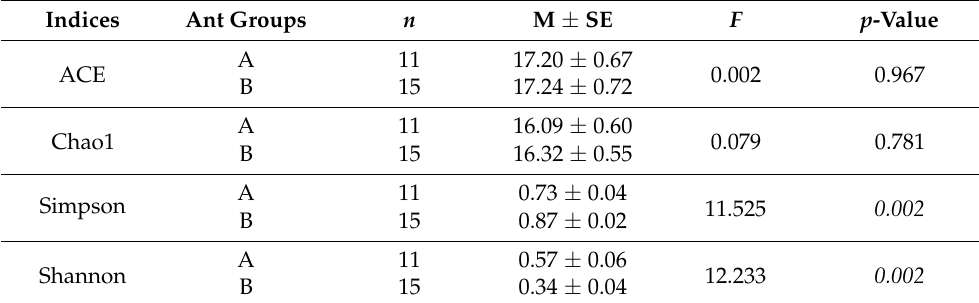
Table 4. Results of one-way ANOVA for the effect of ant attendance on bacterial community diversity of Pseudoregma bambucicola